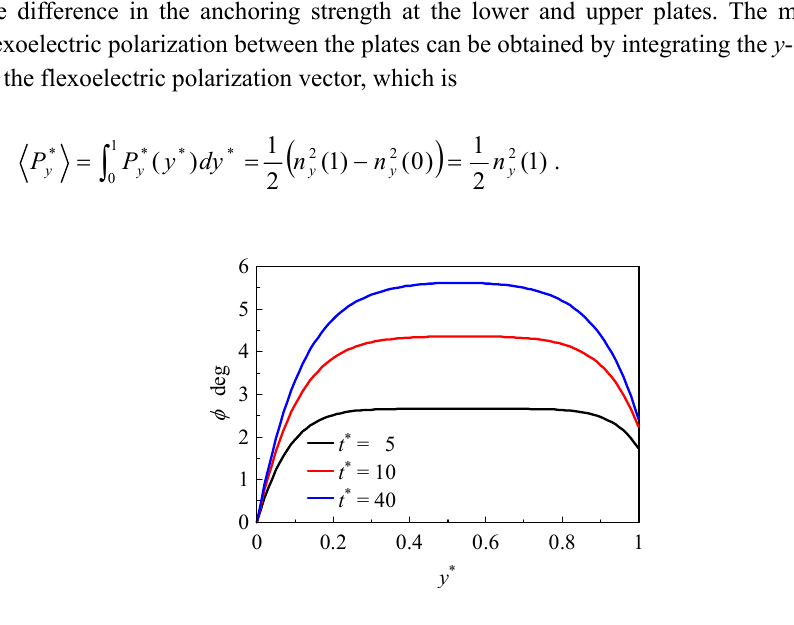
Fig.3 Director angle profiles for Er=500 and Ae=100